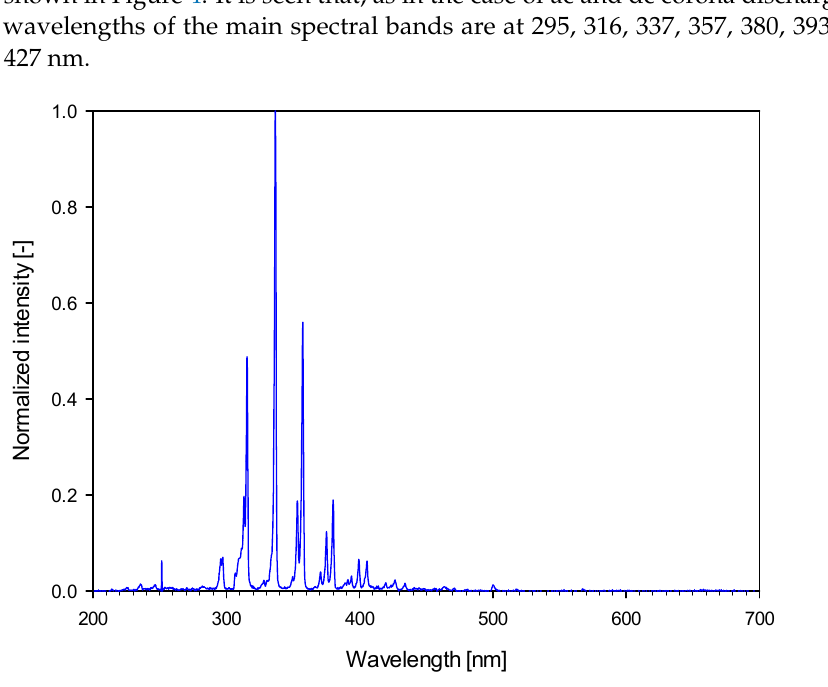
Figure 4. Electric arcs without forced ventilation. Normalized spectra with 50 Hz ac supply at 43 kV, using a needle-plane gap (diameter = 3.5 mm, gap = 70 mm). The air in the discharge region was then replaced by forced ventilation using a fan.